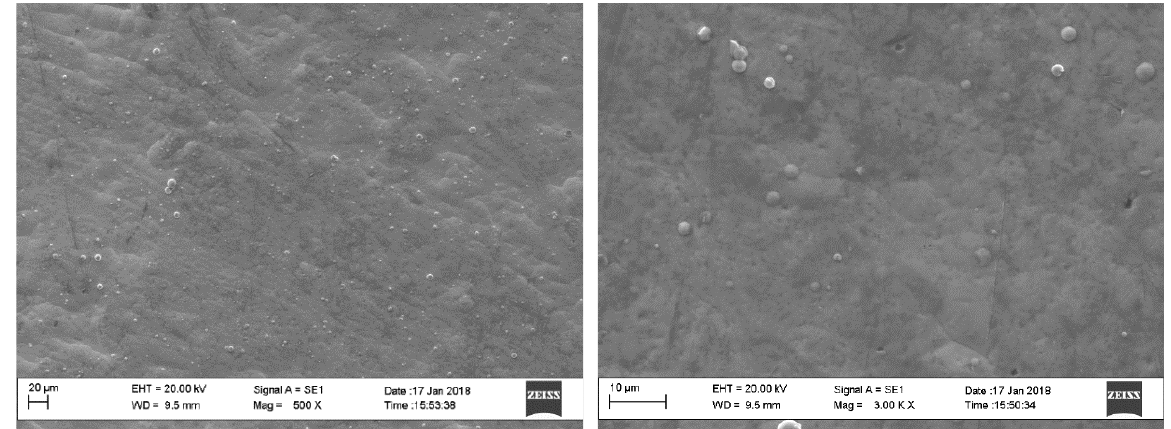
Figure 3. Surface morphology (SEM images) of the heat-treated electroless Ni coating with embedded c-BN nanoparticles (Ni-BN HT ) at different magnifications.